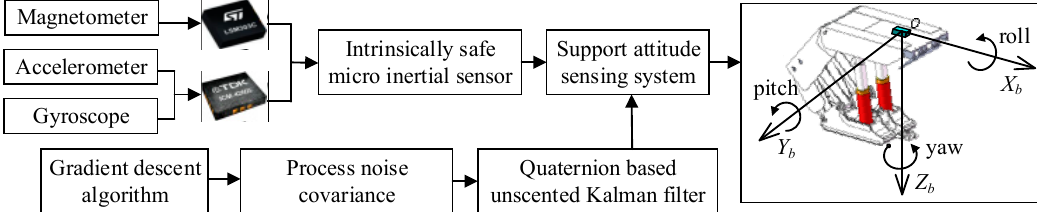
Figure 3. Block diagram of support attitude sensing system based on unscented Kalman filter for attitude measurement according to the complementary characteristics of the MEMS inertial sensor.